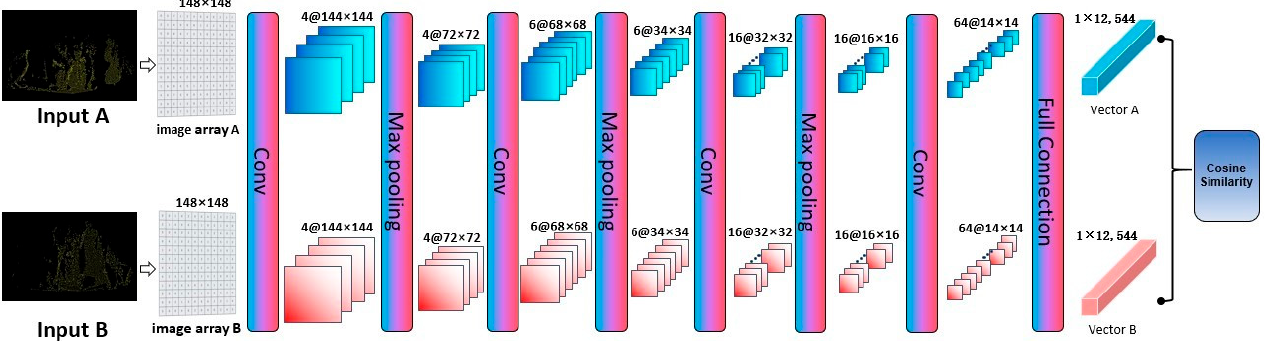
Figure 4. Structure diagram of convolutional neural